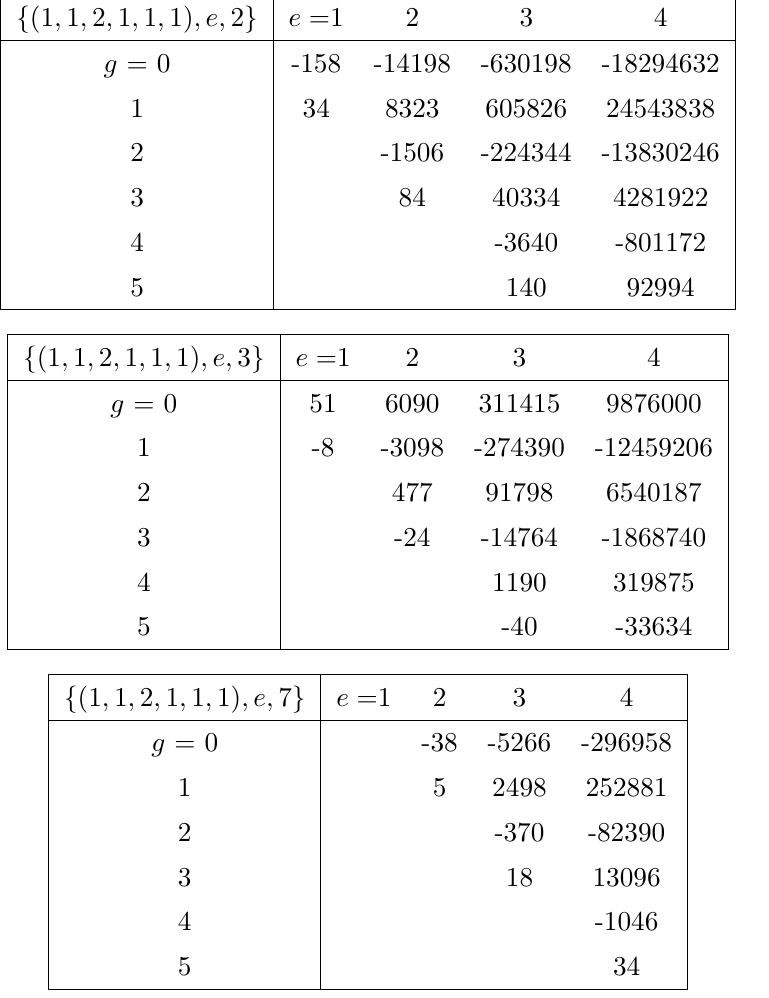
Table 9 . Unrefined GV invariants from (2,0) E 6 SCFT at base degree (1,1,2,1,1,1), fiber degree 1 to 4 and mass degree 2, 3 and